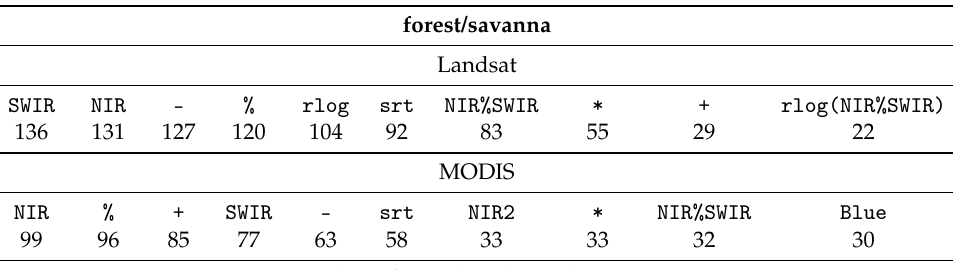
Table 9. List of the most frequent formula elements for the three classification